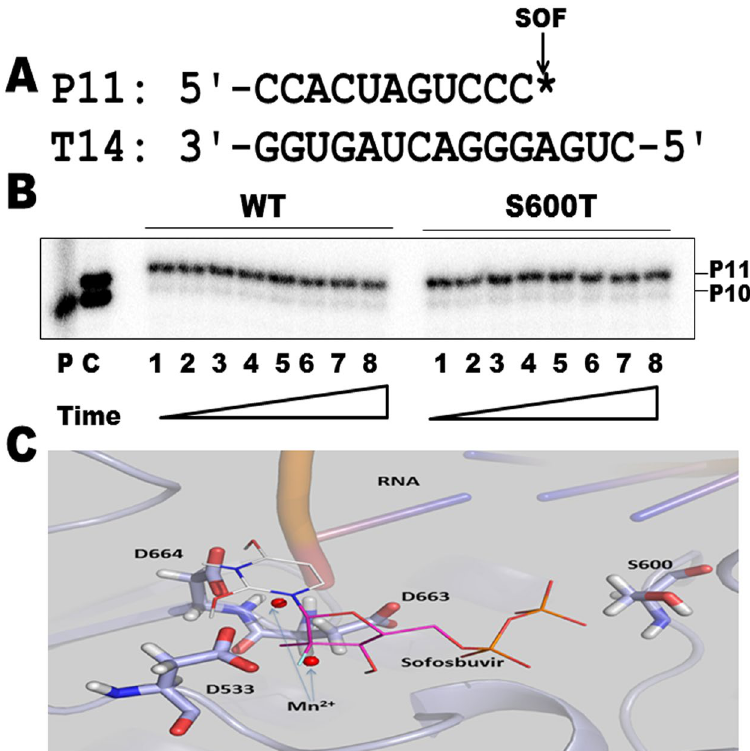
Figure 5. ATP-dependent excision of 3 ′ SOF-terminated primer and docking of SOF-TP into the active site of DENV polymerase in a homology model. ( A ) Sequences of the SOF-terminated RNA primer P11 RNA and the RNA template T14 used in the ATP-dependent excision assay. The position of incorporated SOF is indicated by “ * ”. ( B ) Time course of the excision reaction. The SOF-terminated primer P11/ RNA template T14was incubated with DENV NS5 WT or S600T mutant in RdRp assay buffer in the presence of 3.2 mM ATP. An aliquot of reaction mixture was removed at various time points. Lanes 1 to 8 represent time points at 15, 30, 45, 60, 75, 90, 105, 120 min. P: 5 ′ -end radiolabeled RNA primer P10. ( C) partially extended RNA primer P10 by incorporation of SOF-TP at the + 1 position as size markers. Samples were analyzed using denaturing PAGE (20% acrylamide, 7 M Urea) and phosphorimaging. Positions of primers P10 and P11 are indicated on the right.(C) Catalytic residues D533, D663, and D664 are in close proximity to coordinate both Mn 2 + cations (red circles). SOF-TP is shown in lines. The catalytic triad residues D533, D663, and D664 are shown in sticks. Mn 2 + cation binding was mimicked by direct structure overlay from the HCV NS5B crystal structure (PDB ID 4WTG). A short double stranded RNA was retrieved from the PDB structure 4WTG and overlaid into the homology model structure. Structure visualization was performed using